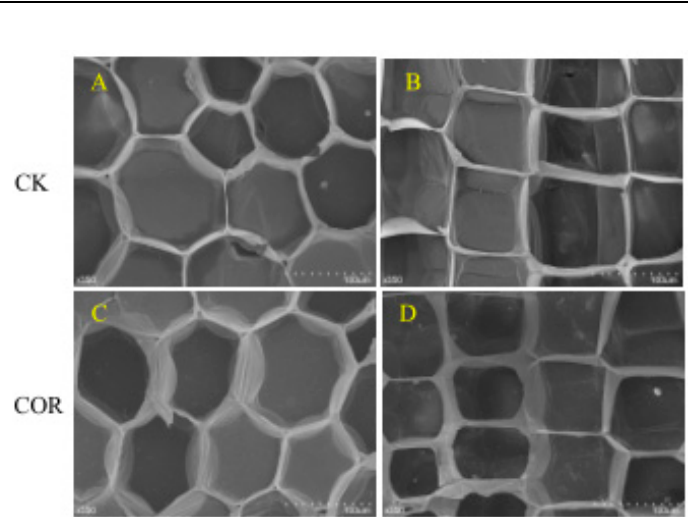
Figure 6. Scanning electron microscopy of the transverse and longitudinal structure of cells in the middle of the third basal internode of maize stalks at 15 days after COR was sprayed onto foliar surfaces. CK: control, COR10: 10 µmol L − 1 COR treatment. ( A ) and ( C ) show transverse sections of the internode, and ( B ) and ( D ) show longitudinal sections of the inthenode.